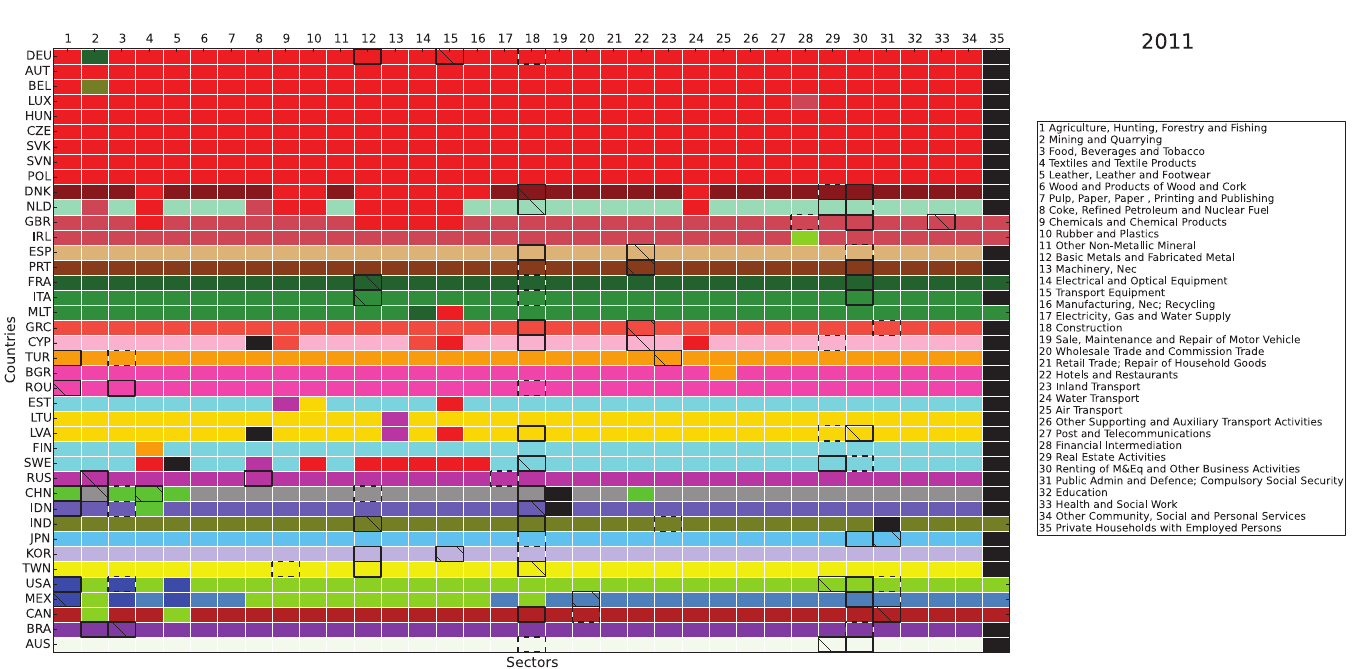
Fig 10. Community detection and community core detection results in 2011. The economies are arranged by rows and the industries are arranged by columns. Each color represents a community detected, except that the black color indicates the isolated nodes with only self-loop. Within each community, the top 3 core economy-industry pairs are identified. The first place is with thick and solid border. The second place is with thick and dashed border. The third place is with border and texture.